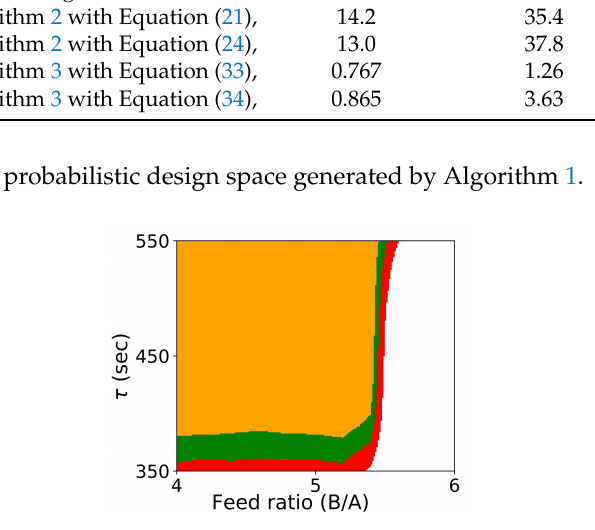
Figure 1. Probabilistic design space for Case Study 1 using Algorithm 1. (orange: p ≥ 0.85; green: 0.7 ≤ p < 0.85; red: 0.5 ≤ p < 0.7).